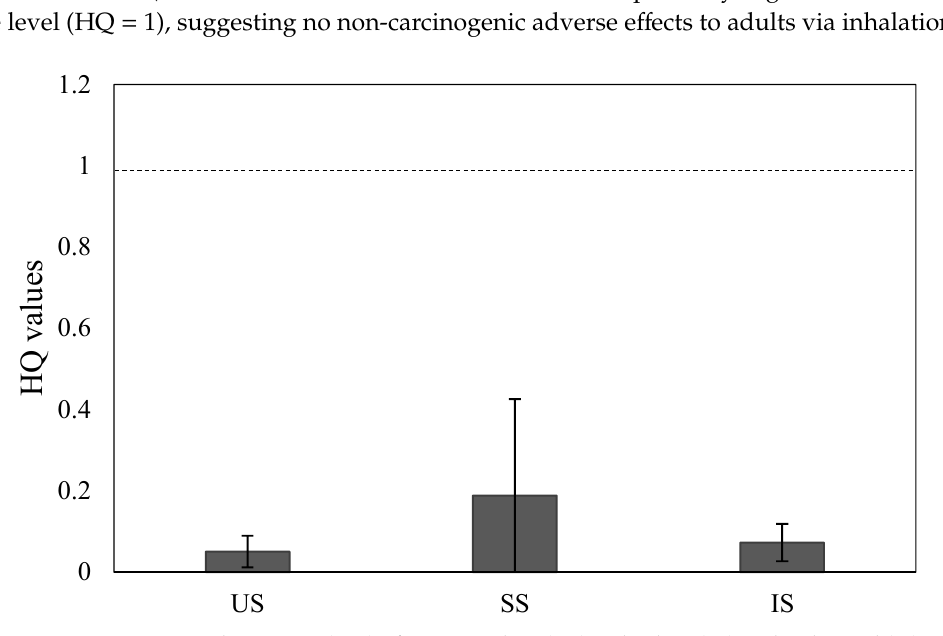
Supplementary Materials: The following are available online at www.mdpi.com/xxx/s1, Table S1: Average, RSD, range and minimum and maximum values of major ions, metals, eBC and UVPM in PM 10 samples at urban site (US) N = 44, suburban site (SS) N = 38 and industrial site (IS) N = 41, Table S2: Seasonal variation of major ions, metals, eBC and UVPM in PM 10 samples at urban site US (summer season N = 22, winter season N = 22), suburban site SS (summer season N = 17, winter season N = 21) and industrial site IS (summer season N = 18, winter season N = 23).